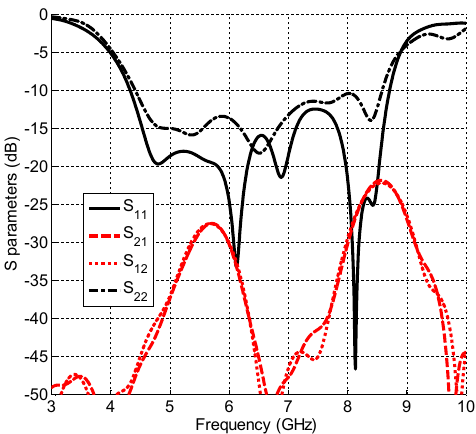
Figure 12. S parameters for antenna in orthogonal configuration.